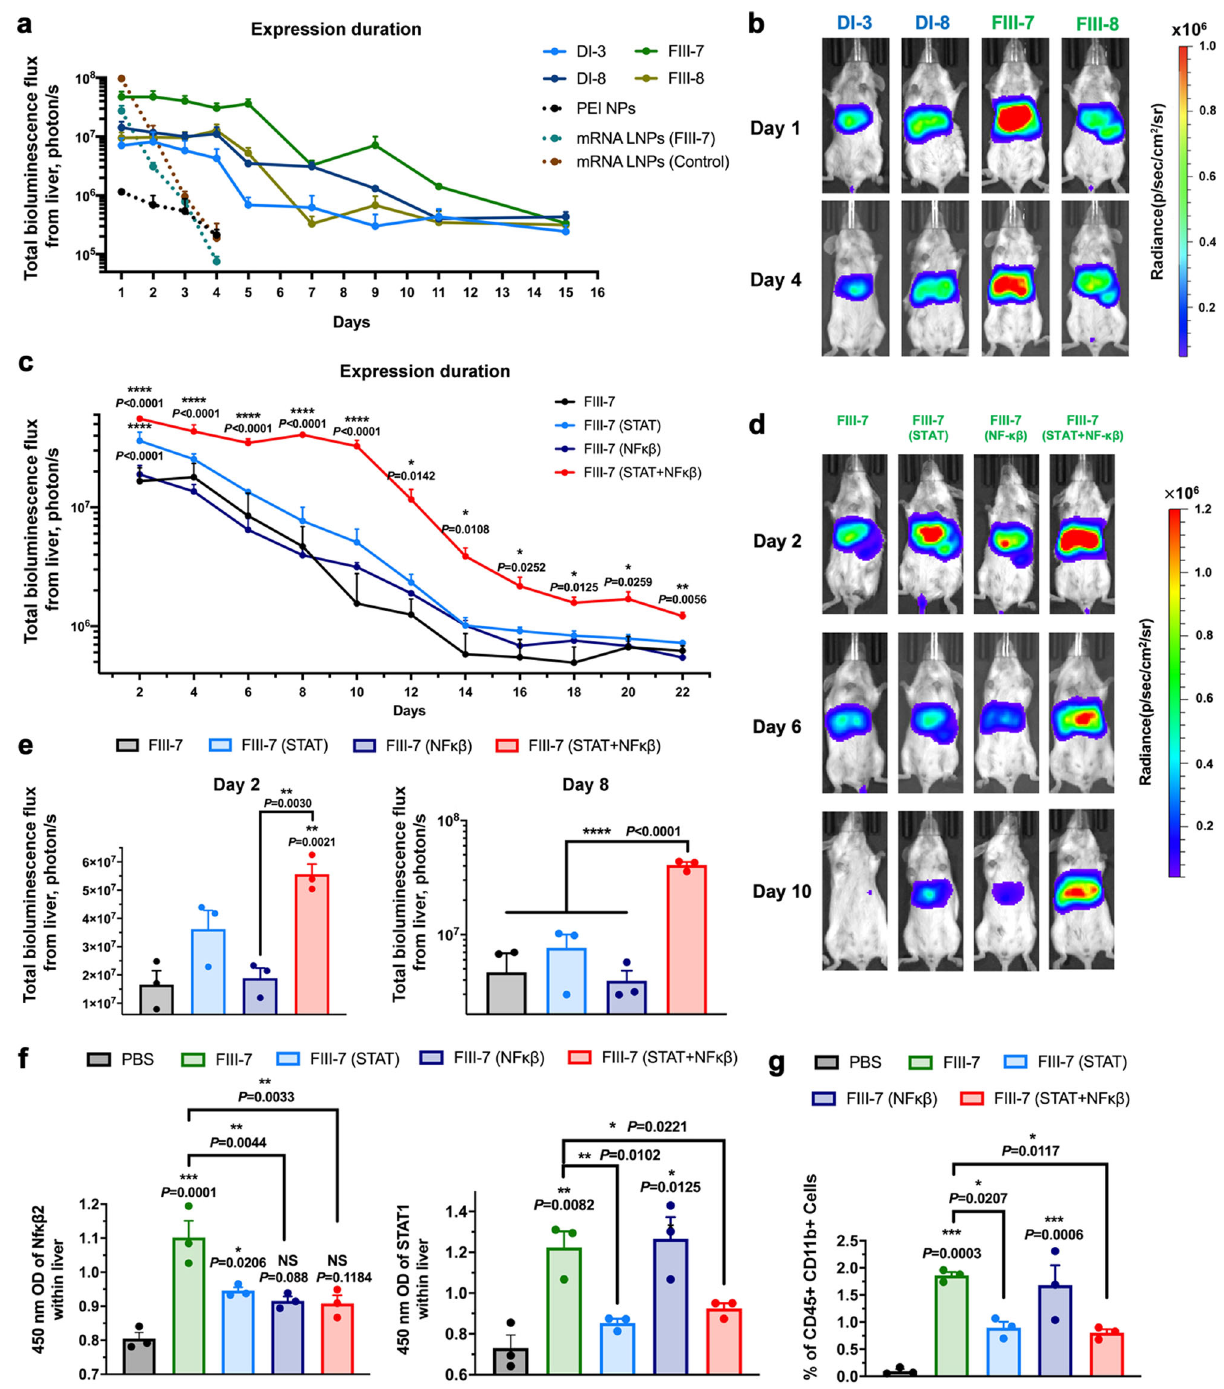
f The levels of transcription factors of treated mice were determined by ELISA at 7 days post-administration with single dosage. (female BALB/c mice (6 – 8 weeks), n =3, 15 mice in total) g FACScan was used to determine the in fi ltrating in fl am- matory monocytes (CD45 + CD11b + cells) in the liver after treatments. ( n =3) Data abovearepresentedasmean±S.E.M.Datawereanalyzedusingone-wayANOVAand Tukey ’ s multiple comparisons test (two-sided) for Fig. 7c, e, f and g. Statistical P - values: No signi fi cance: NS; * P <0.05, ** P <0.01, *** P <0.001, **** P <0.0001. Without speci fi cindications,thelabelaboveeachgroupindicatesthestatisticalcomparison with the PBS control group. Source data are provided as a Source Data fi le.